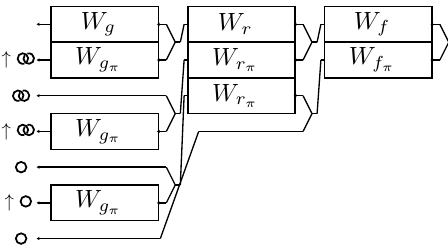
Figure 9: The vulnerability profile of a composition of three functions when considering extended